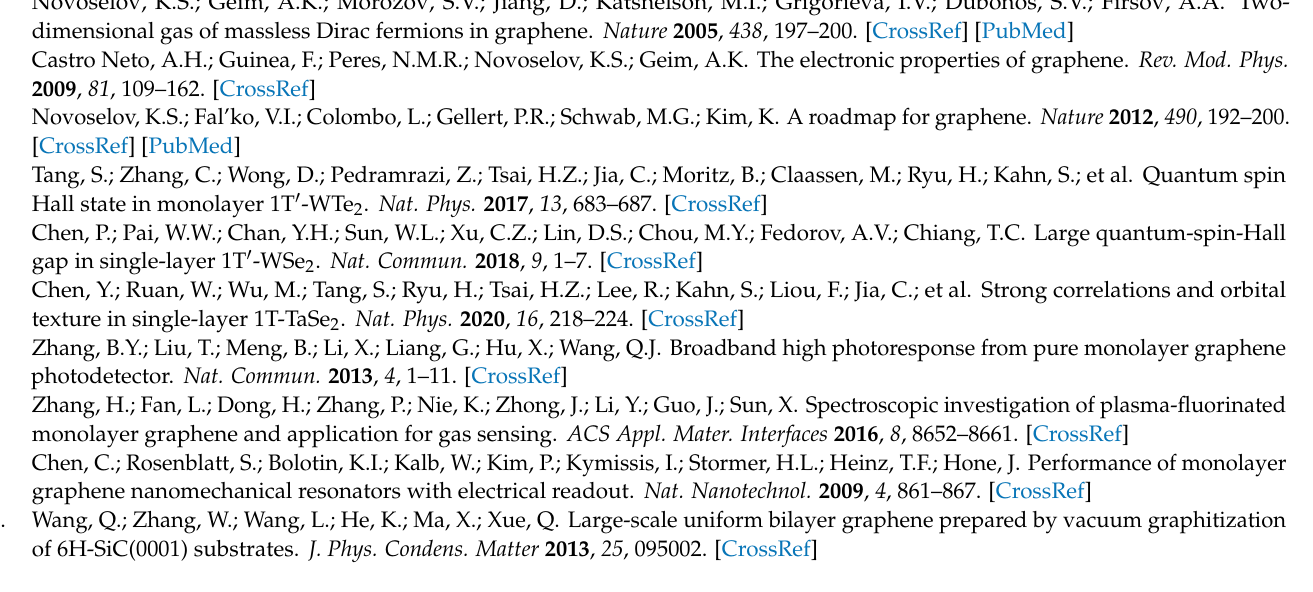
(Figure S6), EDCs of ARPES spectra (Figure S7), FWHM of MDCs at the Fermi level (Figure S8), and XPS N 1s core-level (Figure